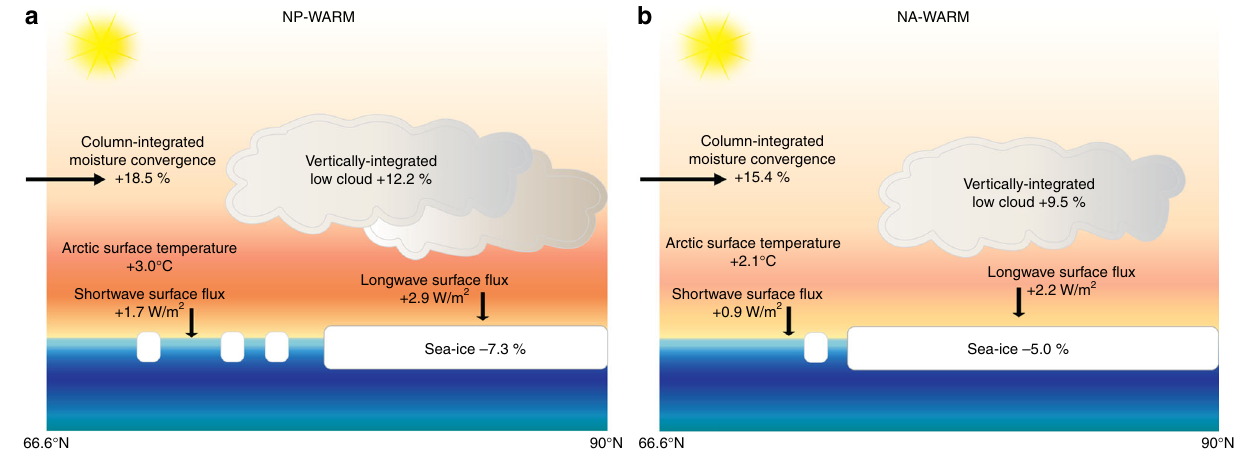
Fig. 6 Schematic of major processes contributing to Arctic surface warming in the NP-Warm and NA-Warm simulations. Enhanced ocean heat fl ux increases the water vapor and latent heat transport into the Arctic, stimulating sea-ice retreat and an increase in low-cloud formation. The reported values are the mean anomalies integrated for the Arctic region for the NP-Warm simulation ( a ) and NA-Warm simulation ( b